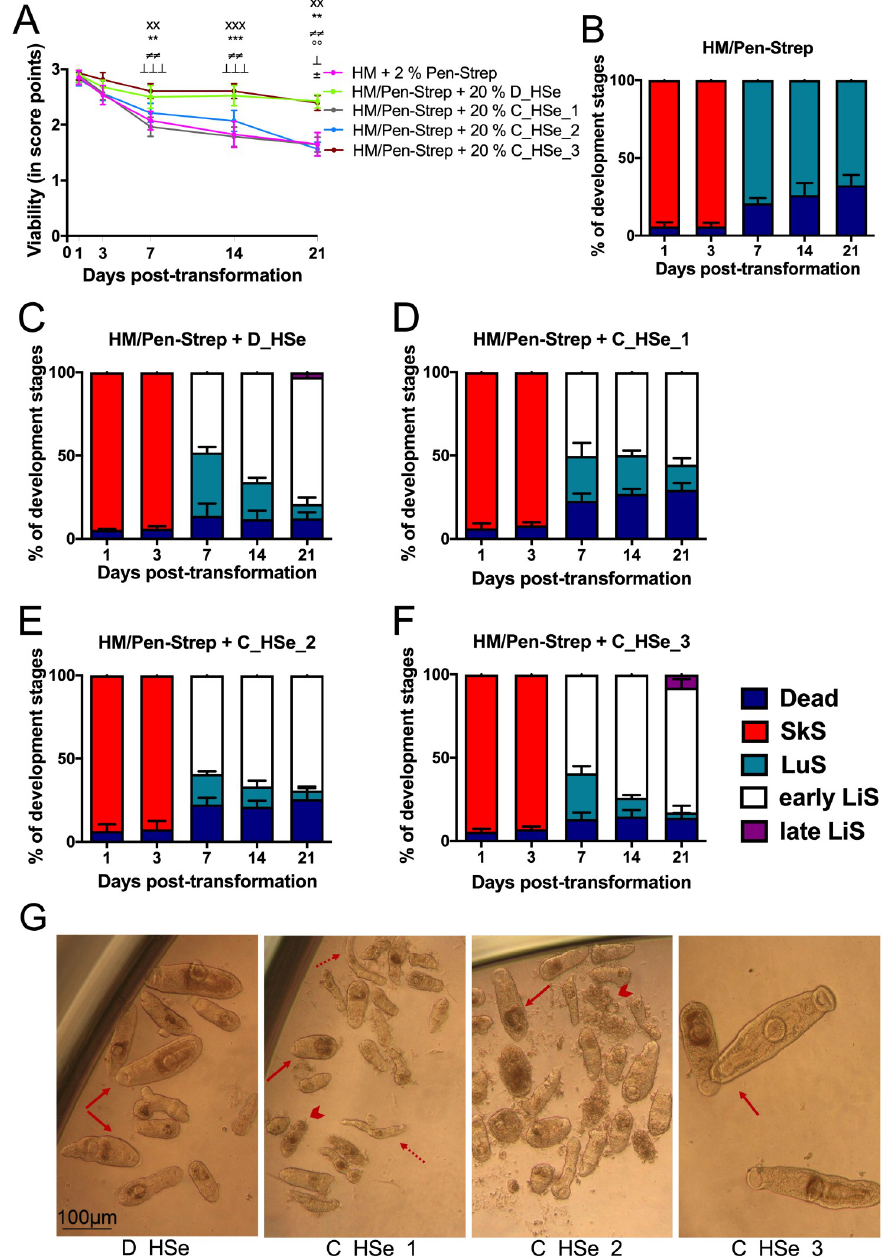
Fig 1. Development of Schisotoma mansoni juveniles in presence of human serum from different sources. Juveniles were cultured in HM supplemented with 200 U/mL penicillin and 200 μ g/mL streptomycin as well as 20% D_HSe (serum from human donors), 20% C_HSe_1 (Commercial human serum from human male AB plasma, H4522), 20% C_HSe_2 (Commercial human serum from male AB clotted whole blood, H6914), and 20% C_HSe_3 (Commercial human serum, pooled, mixed gender, Off clot, S-106B-EU). (A) Viability was scored during bright field microscopy. The percentages of the developmental stages as well as dead parasites in culture with (B) Hybridomed Diff 1000 supplemented with 200 U/mL penicillin and 200 μ g/mL streptomycin (HM/Pen-Strep) or also supplemented with (C) 20% D_HSe, (D) 20% CHSe_1, (E) 20% C_HSe_2, and (F) 20% CHSe_3 at indicated time points and (G) Representative photomicrographs were taken on day 21 post-transformation at 10x magnification. In photomicrographs: broken arrow (lung stage), arrow (liver stage), and arrowhead (dead schistosomula). Results for the percentages of the developmental stages are based on four replicates per condition per time point. Viability results are pooled from three independent experiments with at least three biological replicates each. xx p � 0.01, xxx p �